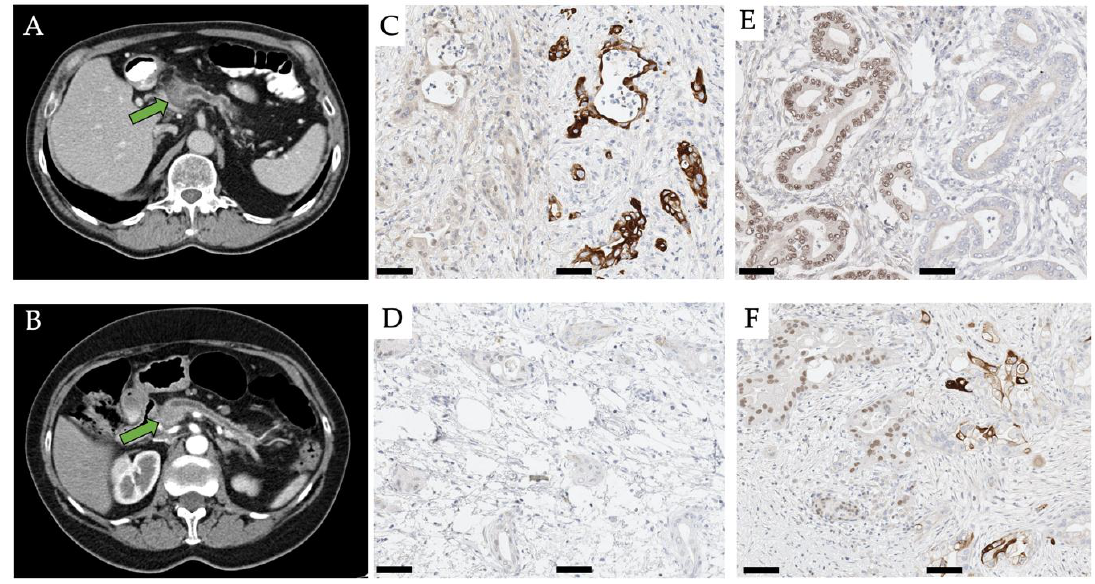
Figure 1. CT images of a patient with a QM ( A ) and a non-QM ( B ) PDAC in the pancreatic head (arrow). Window level 36 Hounsfield-Unit width 350 Hounsfield-Unit in both cases. Micro-photographs of representative immunohistochemical specimens of a HNF1a-/KRT81+ (QM) tumor ( C ), a HNF1a-/KRT81- (non-QM) tumor ( D ), a HNF1a+/KRT81- (non-QM) tumor ( E ) and a HNF1a+/KRT81+ (unclassifiable) tumor ( F ). Scale bar 50 µm. HNF/KRT immunostainings left/right in each subfigure, respectively.